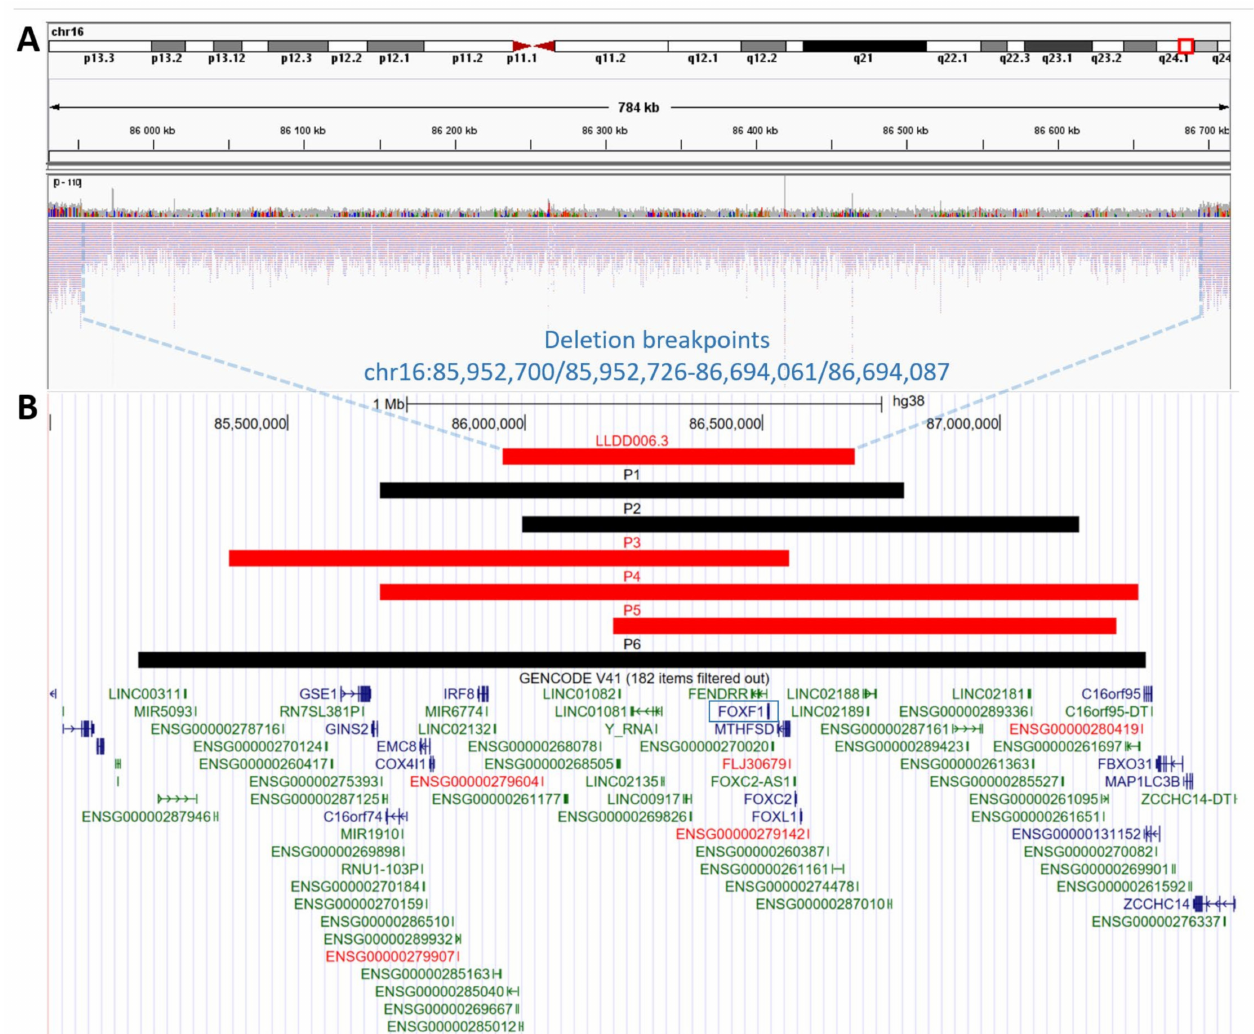
Figure 1. Schematic representation of the copy-number variant (CNV) deletions at 16q24.1 locus. ( A ) Genome sequencing display on Integrated Genome Viewer (IGV) showing a heterozygous ~0.74 Mb CNV deletion (chr16:85,952,700/85,952,726-86,694,061/86,694,087, hg38) in the assessed patient (LLDD006.3). ( B ) Comparison of ACDMPV-related CNV deletion identified in our patient during prenatal testing (LLDD006.3) with six previously described patients with prenatal ACDMPV diagnosis and 16q24.1 CNV deletion (P1 [29], P2 [31], P3 [32], P4 [18], P5 [18], P6 [33]). CNV deletions that arose on the maternal chromosome 16 are marked in red; CNV deletions with unknown parental origin are marked in black. The FOXF1 gene is marked by a blue